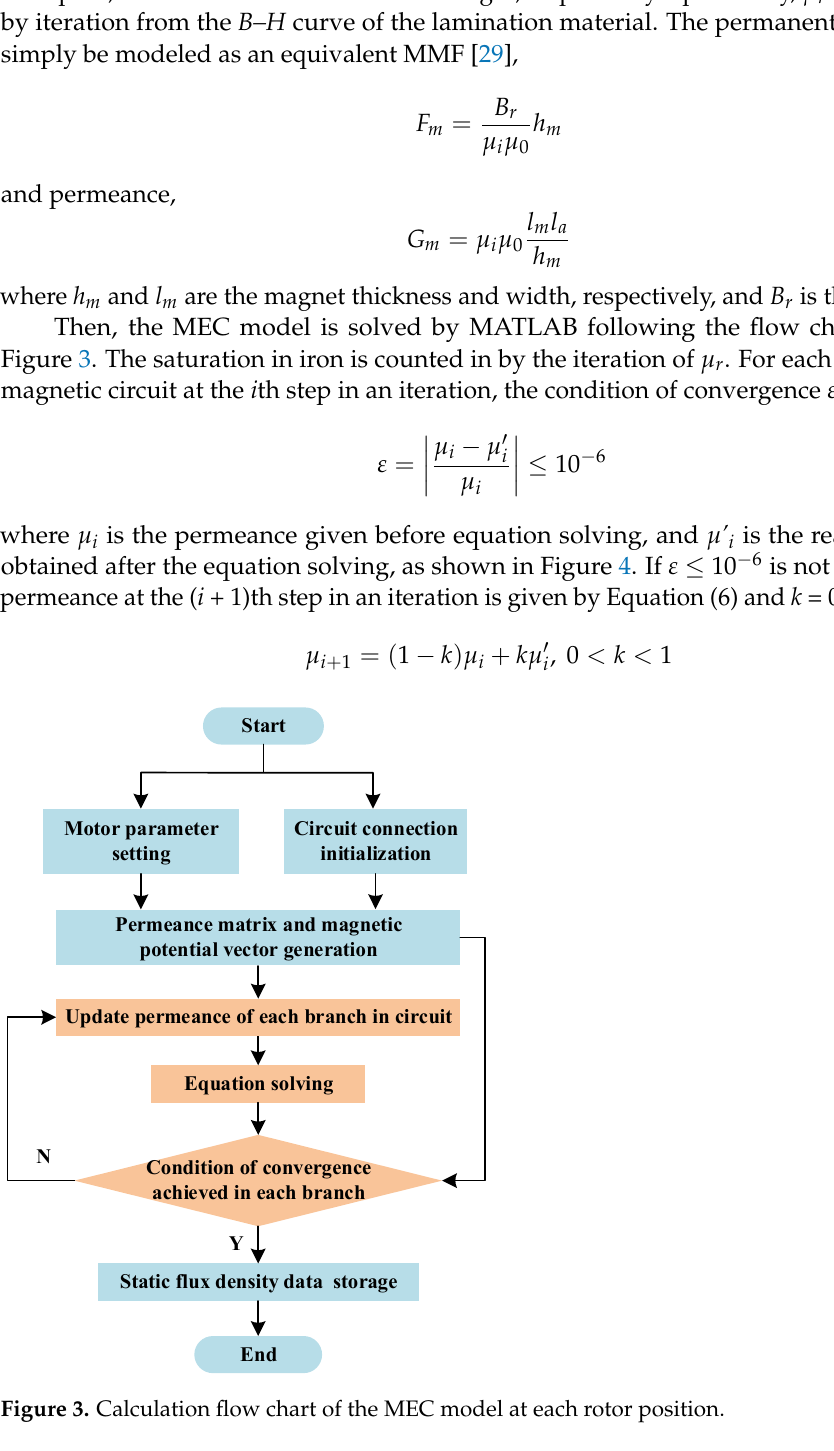
Figure 4. Demonstration of the convergence process according to the B–H curve. Figure 5 shows the mesh results of the FEA model in which the air-gap consists of 6 layers of elements. The path to plot the air-gap flux density distribution is also given in Figure 5a, which covers 1/4 of the air-gap. The air-gap flux density distributions generated by phase-A current, d-axis current and q-axis current, respectively, are predicted by MEC and then compared to the FEA results by Figure 6. Overall, satisfied agreements are achieved.